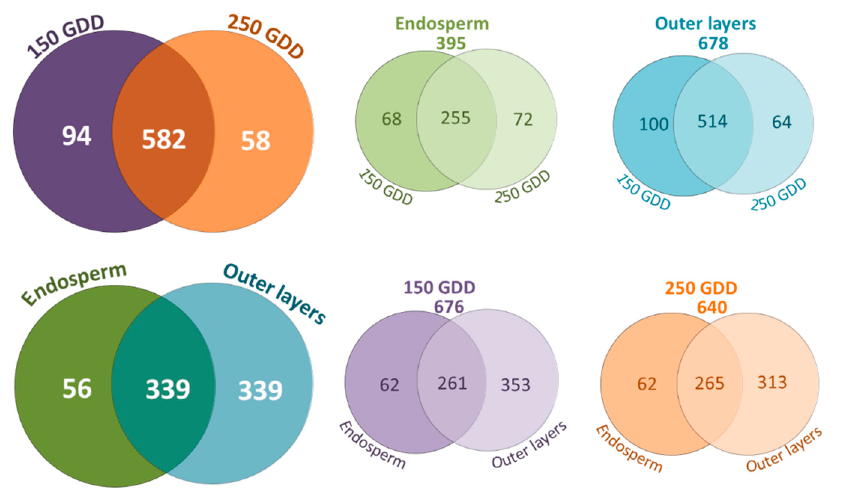
Figure 5. Venn diagrams showing the distribution of CWPs according to the wheat developmental stages and grain parts. stages and grain